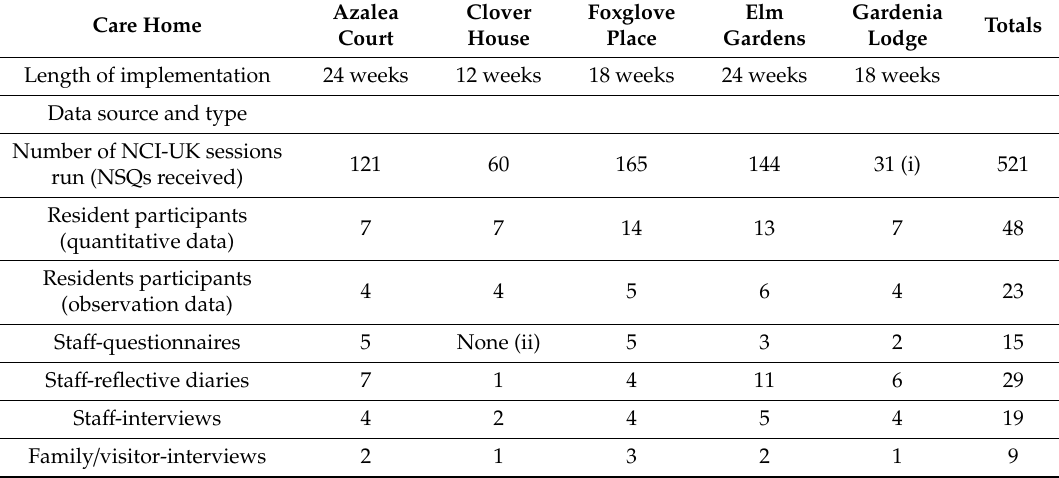
Table 3. Number of participants and data type by care